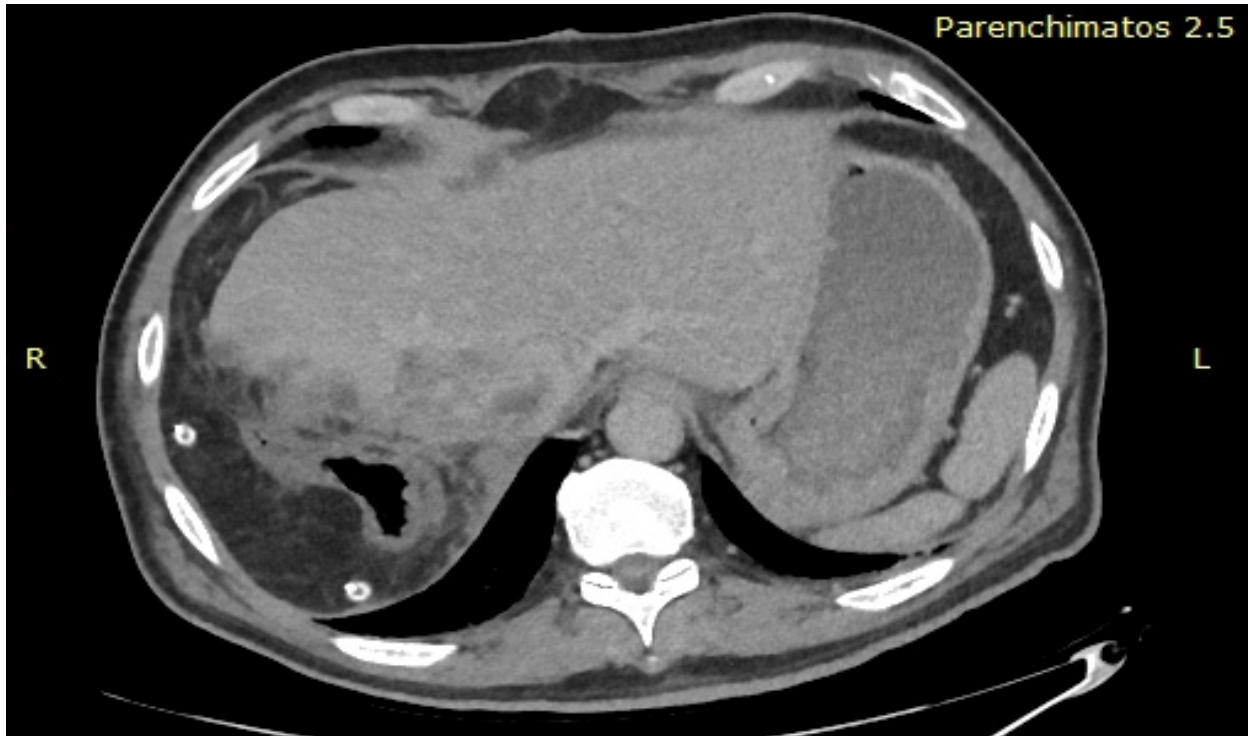
Figure 6. Computed tomography revealing the patency of the graft as well as of the left hepatic pedicle .